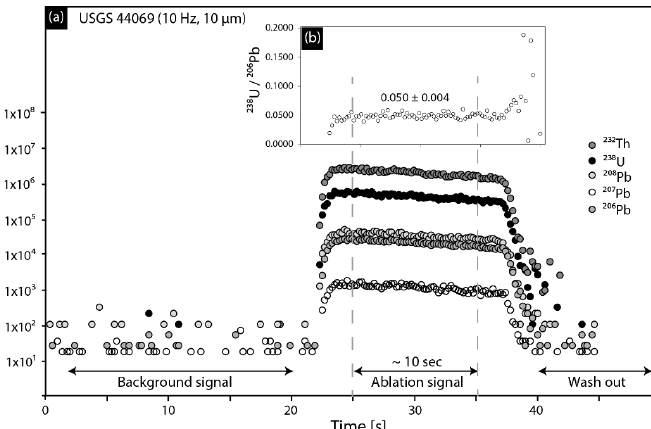
Figure 2. Typical time-resolved ( a ) ablation signal for a 10 µm spot at 10 Hz repetition rate of the calibration RM USGS 44069 (analytical session 130807, Uni Mainz) in counts per second (cps) for all isotopes measured. The ablation signal consists of ~20 s background measurement, ~15 s ablation signal and the first 5 s of the wash out time. The two vertical grey dashed lines within the ablation signal indicate the used signal for data reduction. Plot ( b ) shows the 238 U / 206 Pb ratio of the ablation signal of the same spot analysis. The value represents the mean of the ratio ± 1 RSD